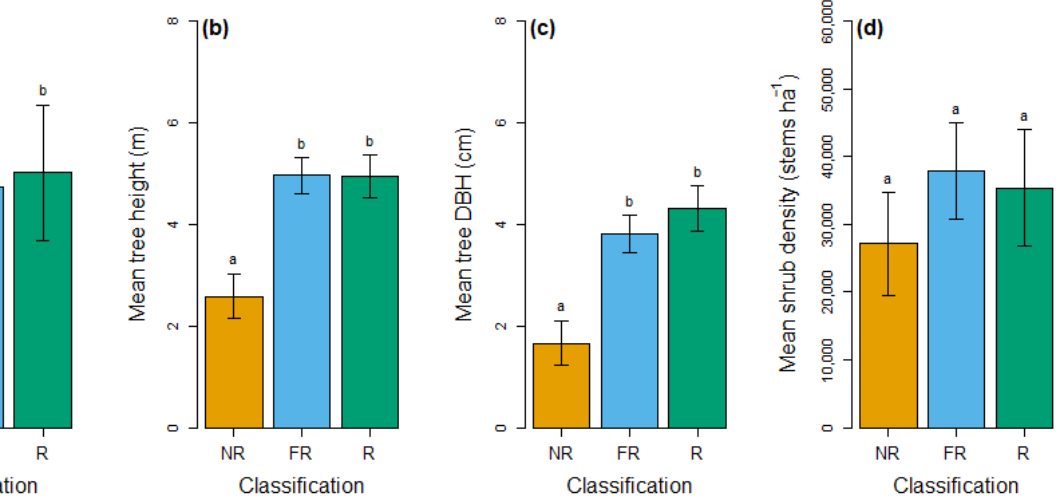
Figure 6. Mean tree density (trees > 1.5 m) ( a ), height (trees > 1.5m) ( b ), DBH (trees > 1.5 m) ( c ), and shrub density ( d ), per classification category: NR (Not Recovered) ( n = 6), FR (Fractionally Recovered) ( n = 10), and R (Recovered) ( n = 6). Error bars represent one standard error of the mean and differing letters between means indicate a significant difference ( p < 0.05).